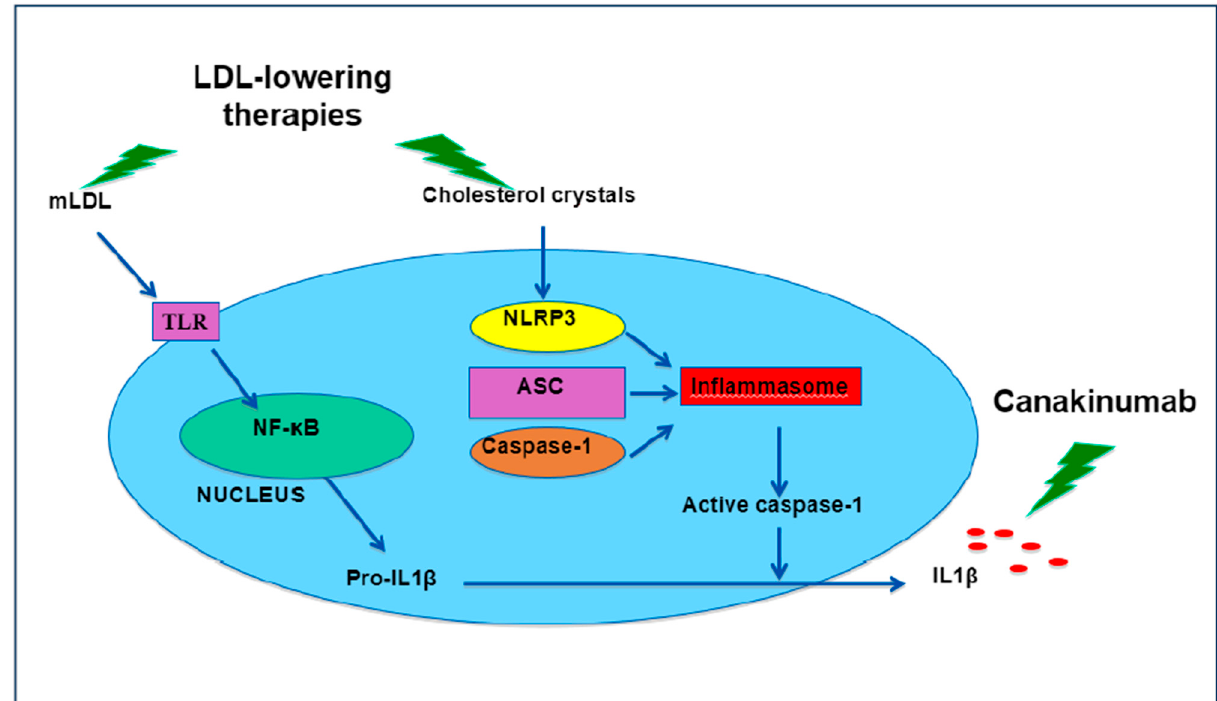
Figure 2. Relationship between lipids and IL1 β activation. Lipids may induce the expression of pro-IL1 β and its transformation into IL-1 β . In this way, lipid-lowering therapy may decrease IL-1 β expression. Canakinumab works on the same pathway blocking the effect of IL-1 β , instead of modulating its expression. Reproduced from reference [83], with permis-